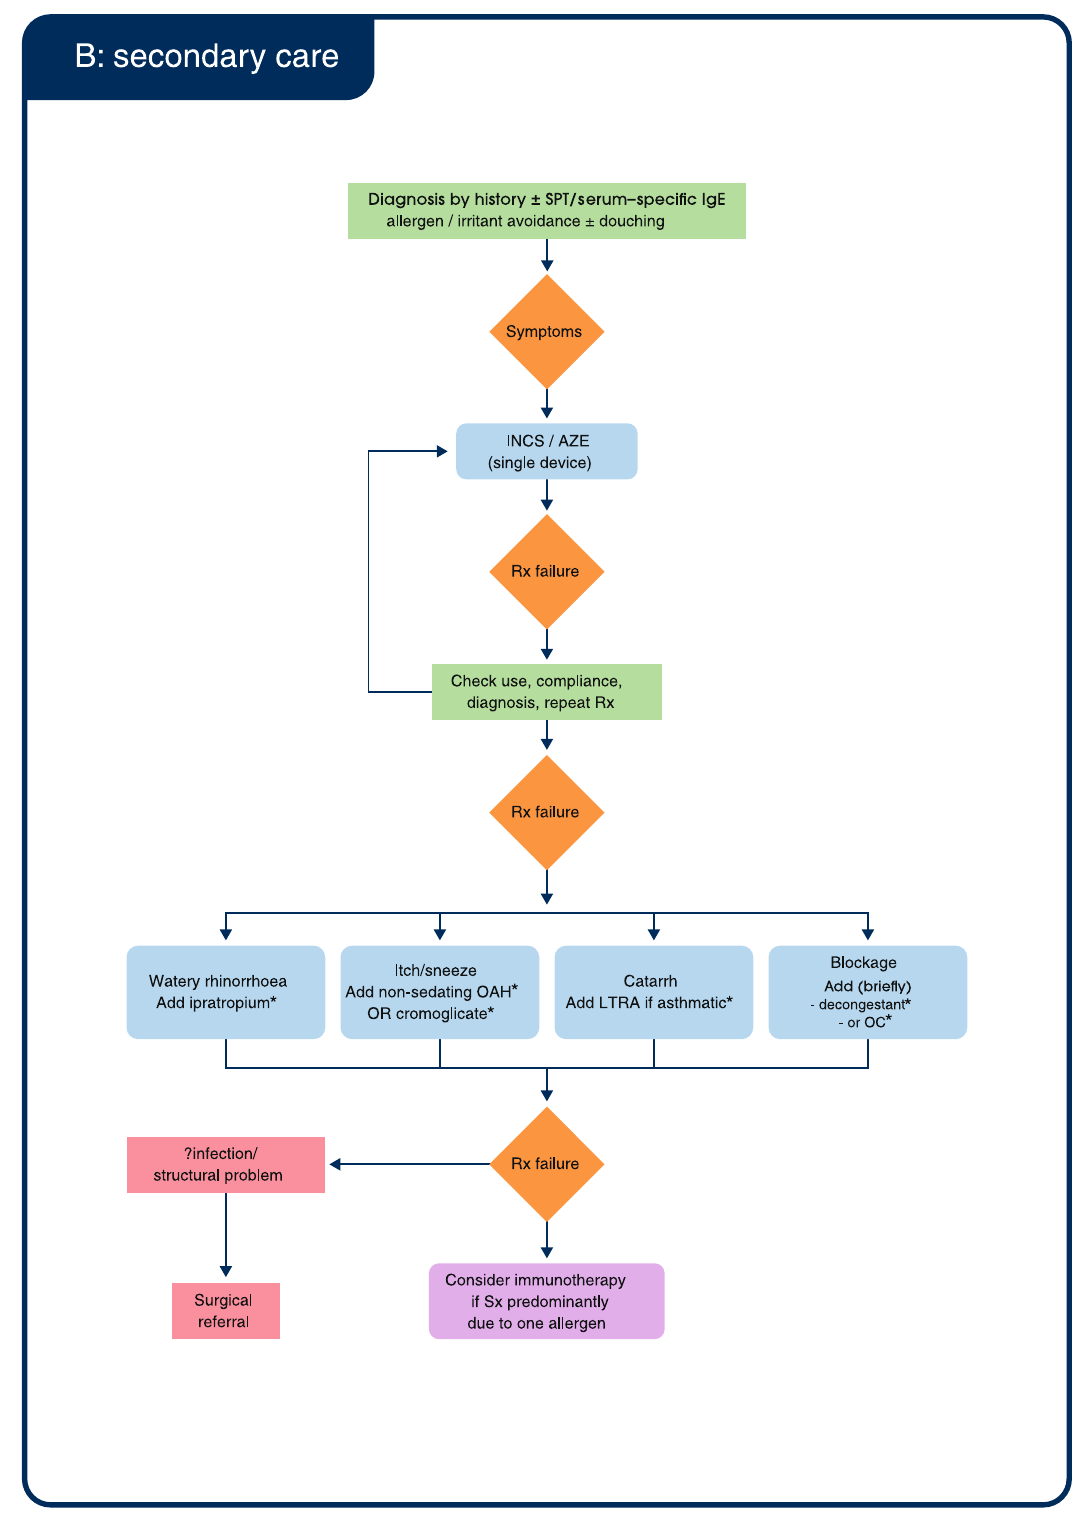
Fig. 2 Treatment algorithm for allergic rhinitis in ( a ) primary care and ( b ) secondary care. AH: anti-histamine; AZE: azelastine; IgE: immunoglobulin E; INCS: intranasal corticosteroid; LTRA: leukotriene receptor antagonist; OAH: oral antihistamine; OC: oral corticosteroid; Rx: treatment; SPT: skin prick test; Sx: symptoms. (a) *You may consider the addition of an OAH to INCS. However, scienti fi c evidence shows that adding an OAH to INCS provides no additional bene fi t over INCS alone. 21, 45 † This consensus group does not recommend routine early use of oral corticosteroids (OC); OC use should be reserved for short-term acute severe symptoms. (b) *Evidence for the bene fi t of these add-ons is lacking. Adapted from BSACI Scadding 2008.